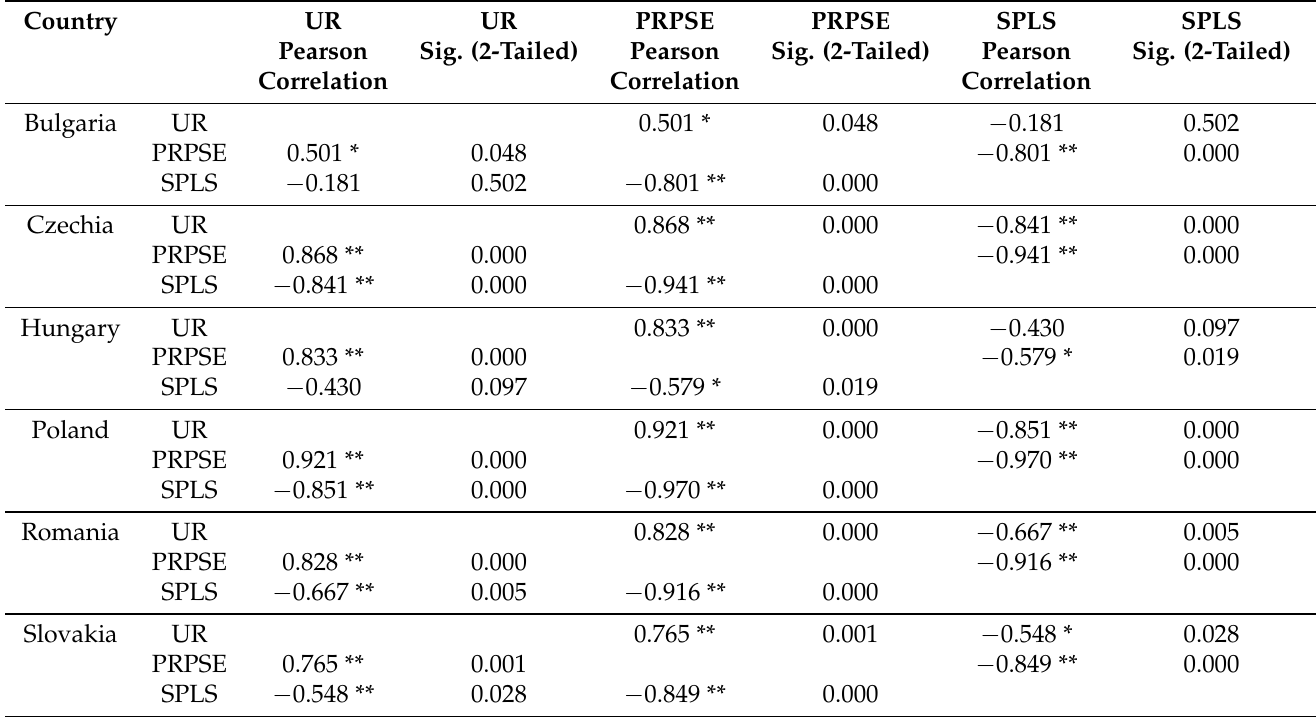
Table 3. Correlations for the selected